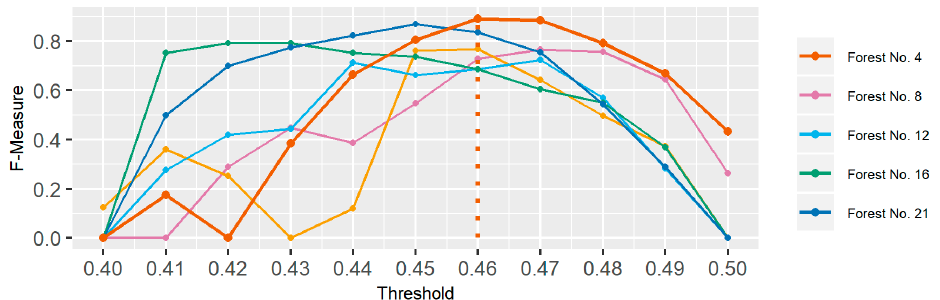
Figure 5. F-Measure for selected OSM mixed forest polygons based on different thresholds. The dotted orange line indicates the optimal threshold for forest area No. 4.